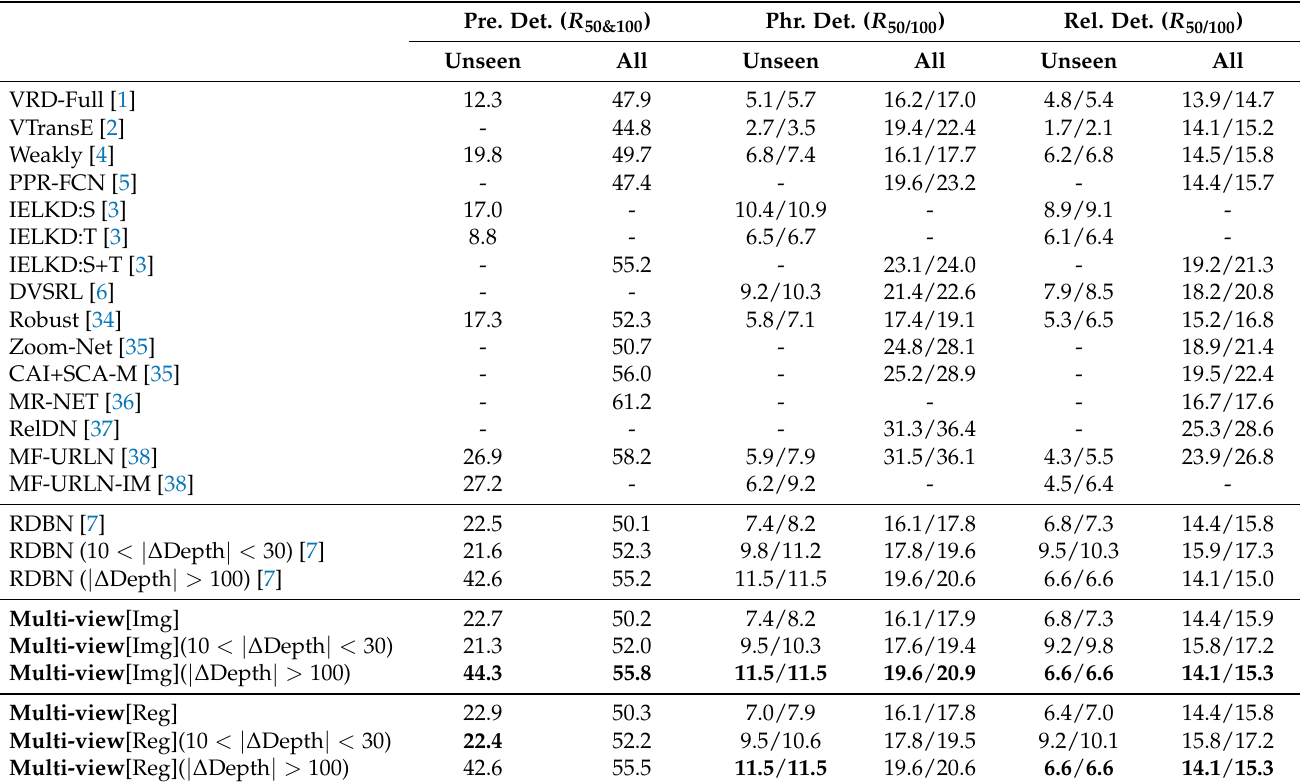
Table 1. Recall performance comparison (%) with existing strong VRD baselines on VRD dataset [1]. Multi-view and Multi-view[Reg] represent multi-view VRD framework with ImageNorm and RegionNorm normalization strategy, respectively. The “Unseen” column shows zero-shot learning performance and the “All” column shows performance in normal dataset condition. “-” denotes the result is unavailable. The best performances in the specific depth condition are highlighted in boldface. Note that in existing methods, only the multi-view framework and RDBN [7] can evaluate the performance in specific depth